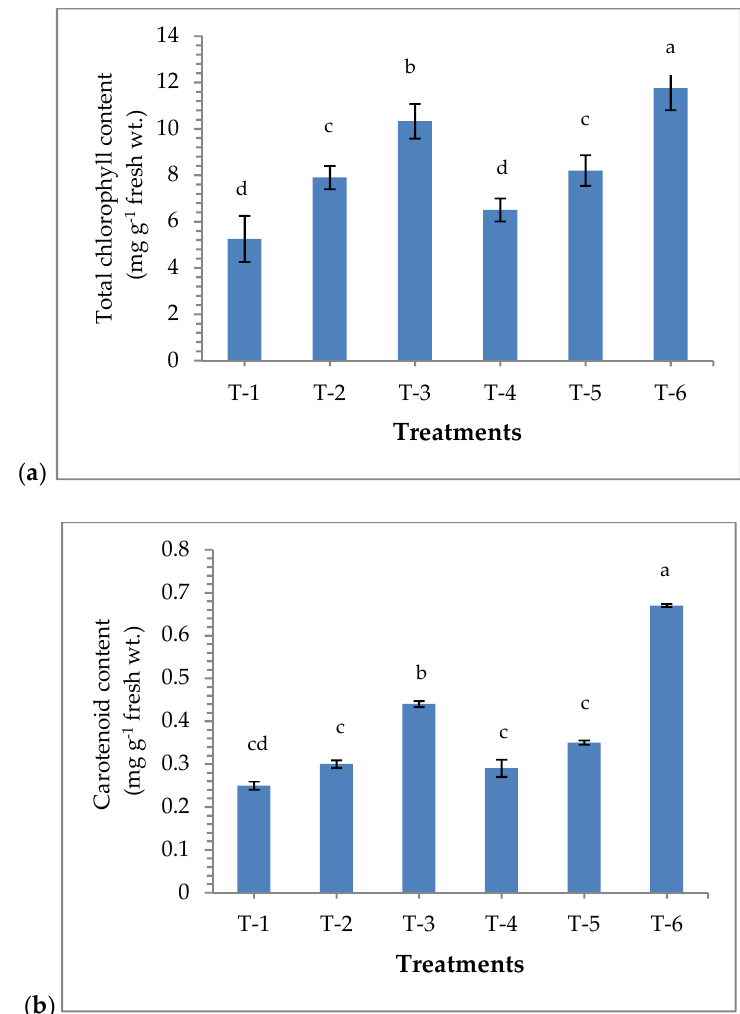
Figure 3. Effects of seed bio-priming and other treatments on ( a ) total chlorophyll content and ( b ) total carotenoids content in maize leaves at 15 DAPI under nethouse condition. Treatments were: T 1 - plants inoculated with R. solani alone; T 2 - R. solani + seed bio-primed with P. aeruginosa MF-30; T 3 - R. solani + seed bio-primed with P. aeruginosa MF-30 + foliar spray of MF-30; T 4 - R. solani + foliar spray of culture filtrate of MF-30; T 5 - R. solani + seed bio-primed with P. aeruginosa MF-30 + foliar spray of culture filtrate of MF-30; T 6 -Control (untreated). Data are mean ± SEM ( n = 5).